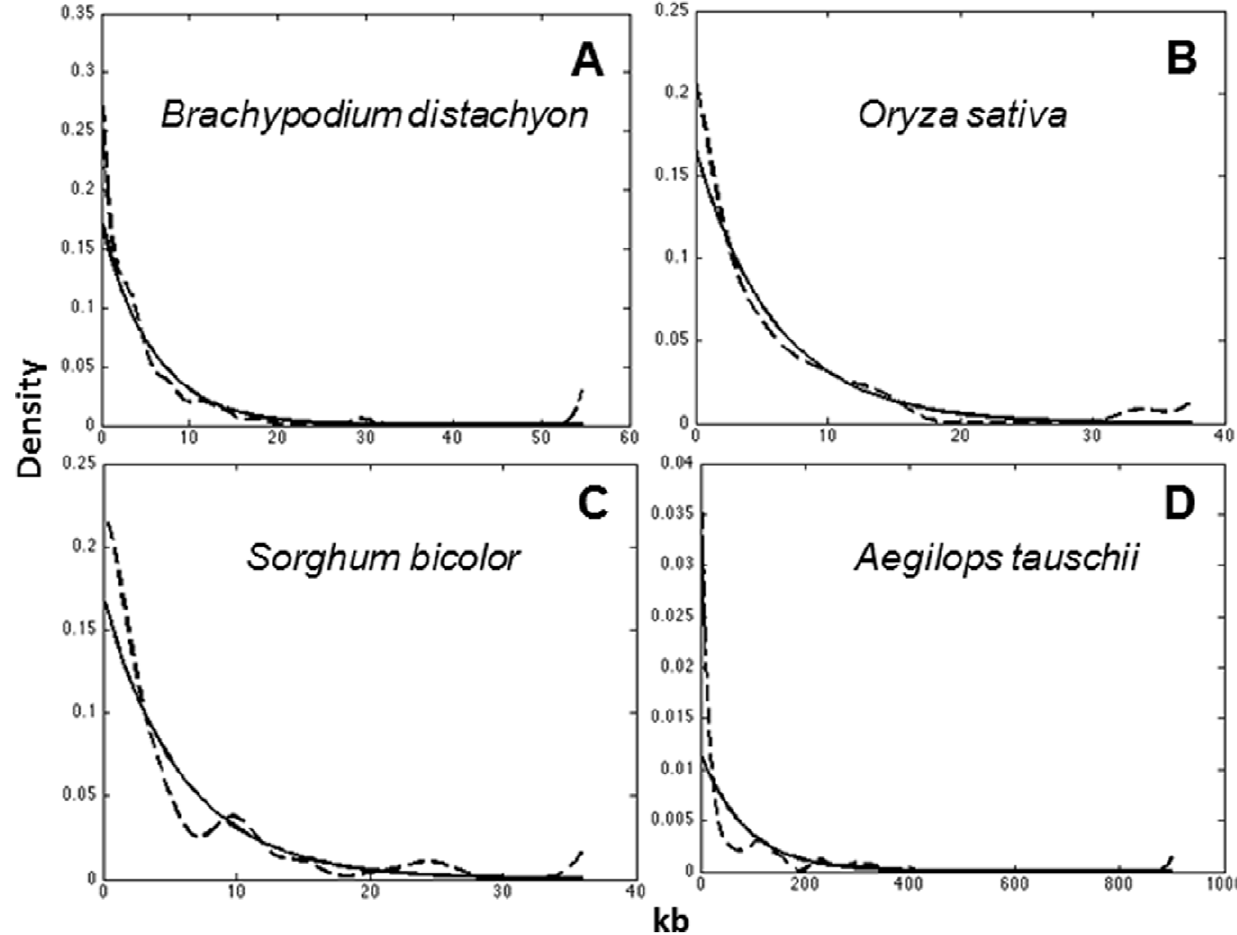
Figure 1. Density functions for intergenic distances in B.distachyon (A), rice (B), sorghum (C), and Ae.tauschii (D). Shown is the exponential density fitted by Maximum Likelihood (2) (solid) and the non-parametric density estimate (4) (dashed), with bandwidth h =1.25 ( A ), h =1.75 ( B ), h =1.50 ( C ), and h =15.00 ( D ).